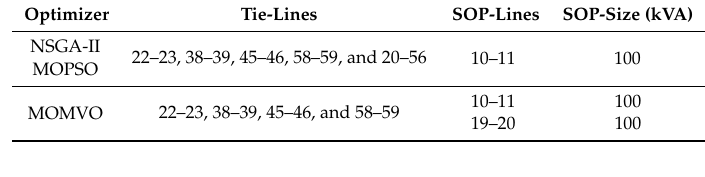
Table 10. Tie-lines, SOPs size, and locations.